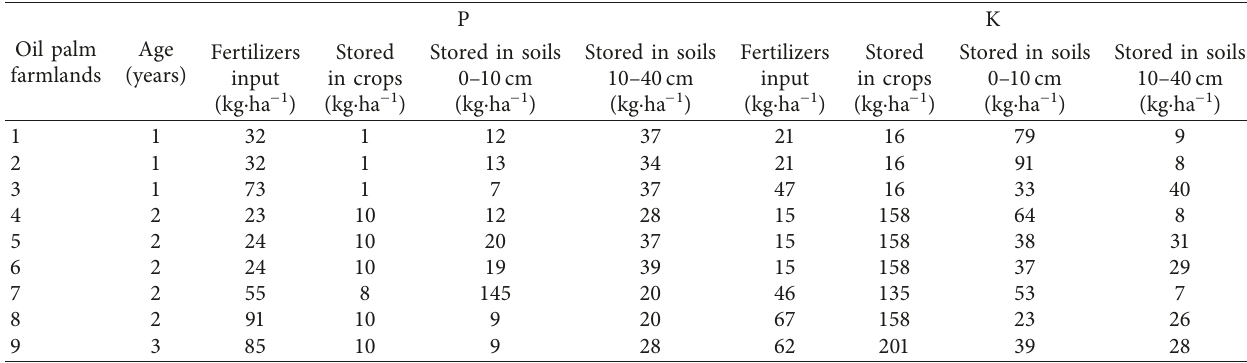
Table 7: Partial nutrient budgeting comparing fertilizer input, crop uptake, and soils (0–40cm) for P and K in each oil palm land use. Oil palm farmlands